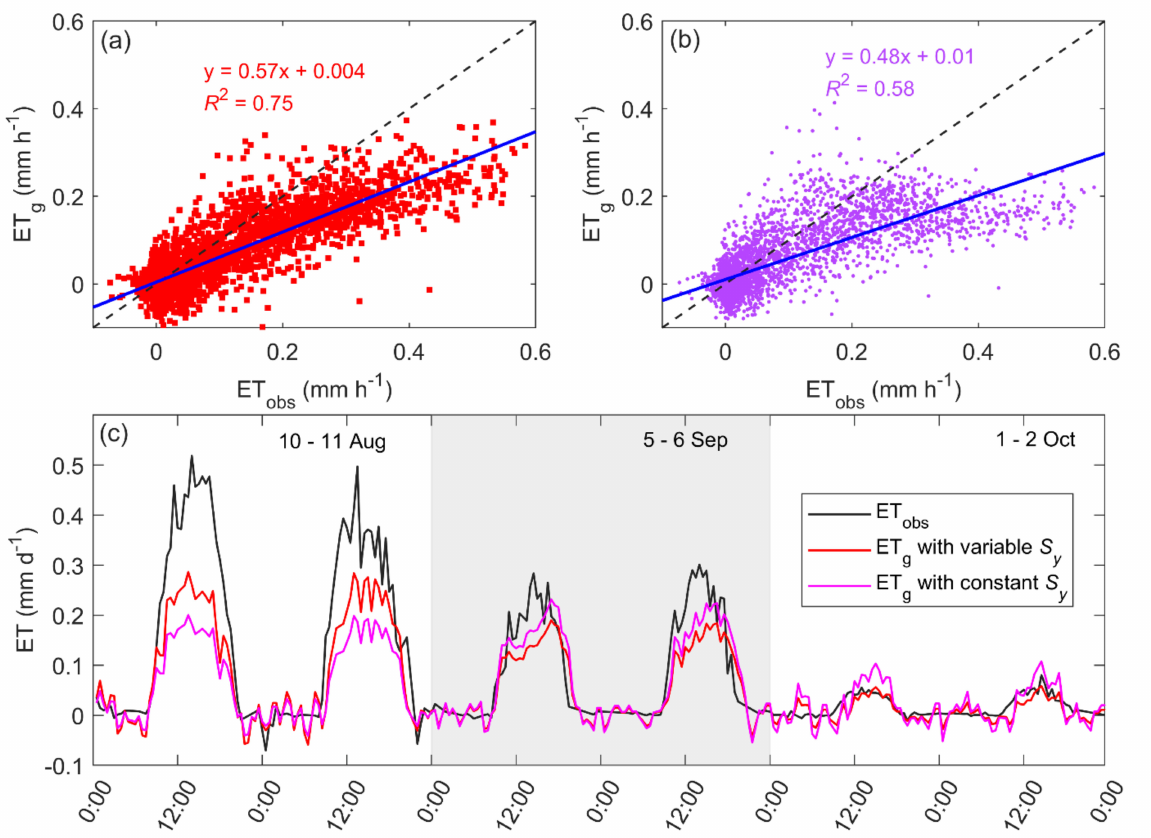
Figure 7. Comparisons between measured ET and estimated ETg at the sub-daily time scale based on different Sy calibration procedures: ( a ) dataset-by-dataset procedure; ( b ) whole dataset pro- cedure; and ( c ) diurnal variations of the measured ET and estimated ETg based on different Sy calibration